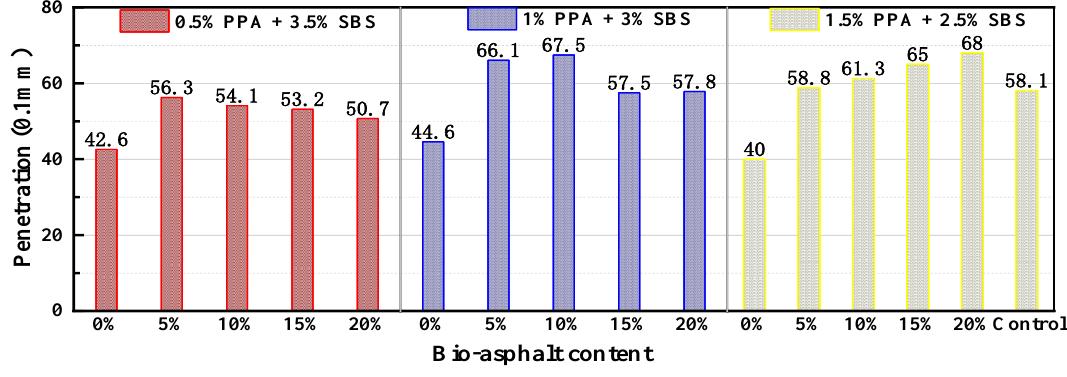
Figure 4. Test results for penetration.